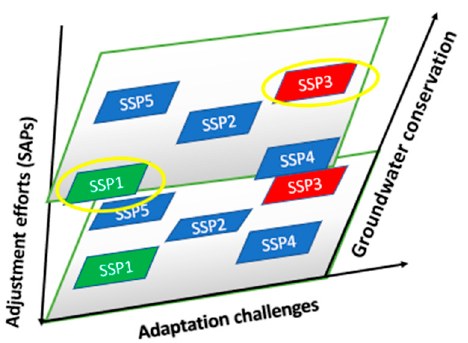
Figure 3. Shared socioeconomic pathways and representative concentration pathways. Source: adopted from [24,25].